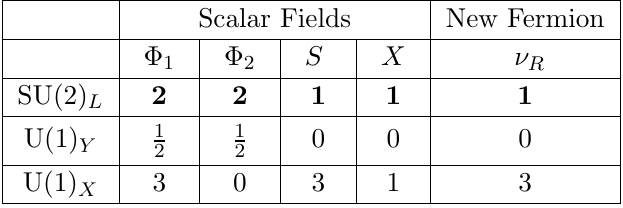
Table 1 . Scalar (cid:12)elds and new fermion in our